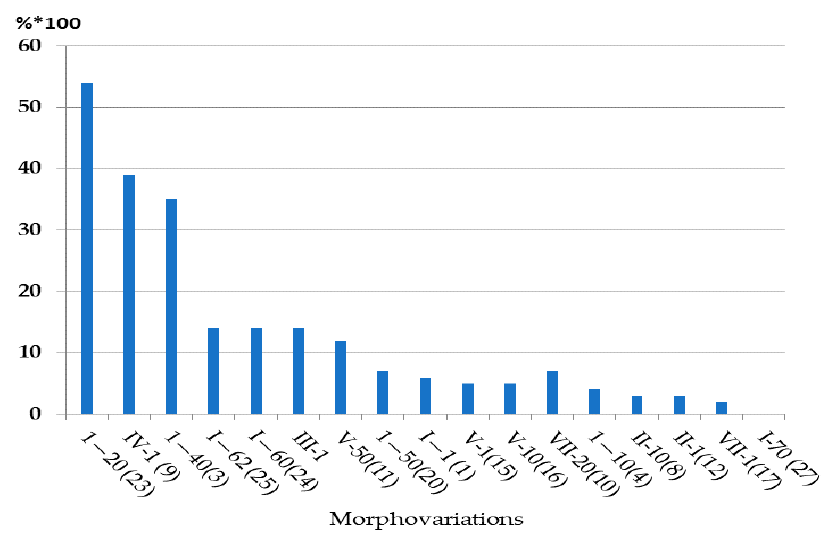
Figure 7. Average frequencies of occurrence of the basic morphovariations of D. pumila ’s stem module (30 samples; 339,629 modules).